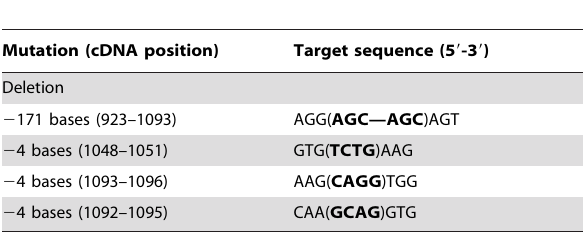
Table 3. Spontaneous mutational spectrum of PIG-O gene in DT40 cells.